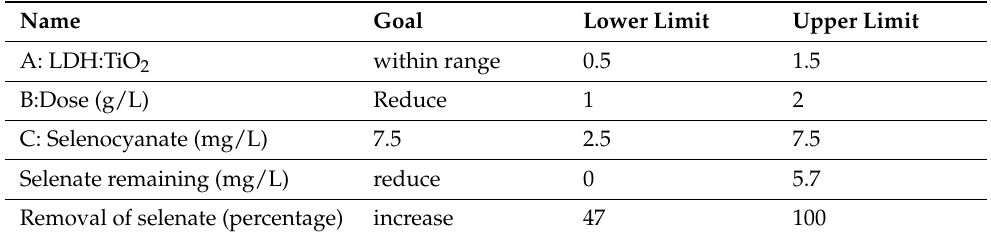
Table 6. The constraints employed for RSM modeling for the photocatalysis work.